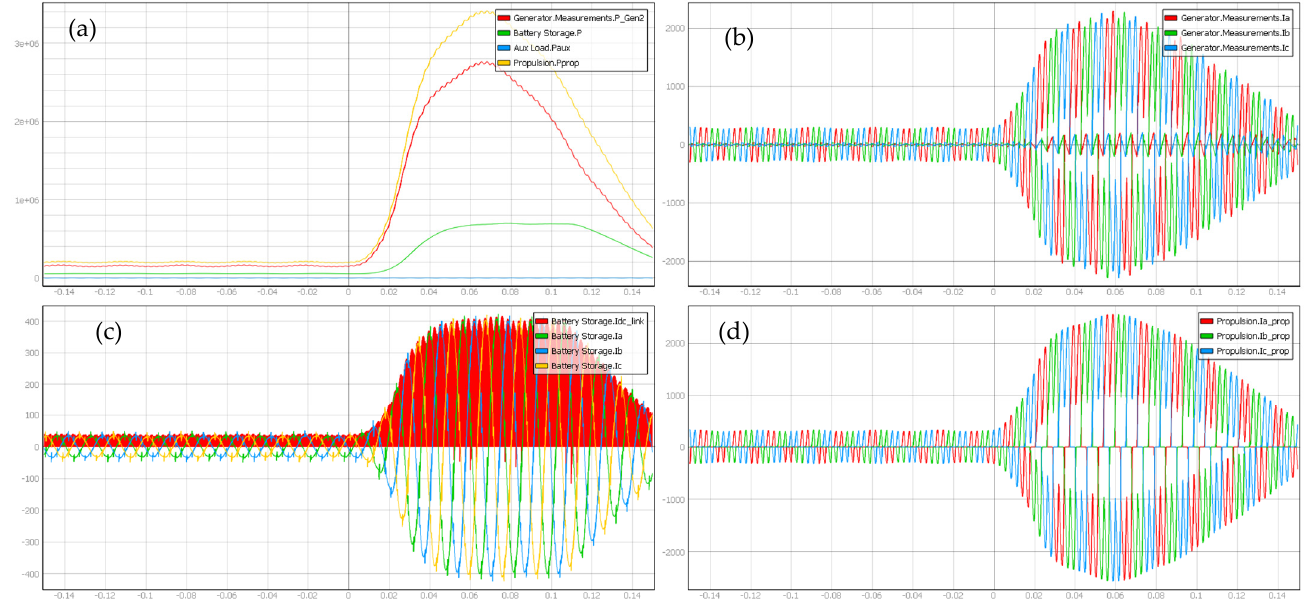
Figure 10. Results of case study 2/scenario A. From left to right, top to bottom: ( a ) power associated with diesel generator, battery, auxiliary load and propulsion system; ( b ) diesel generator currents; ( c ) battery currents (at the battery itself and at the output of the filter); ( d ) input currents to the propulsion system.